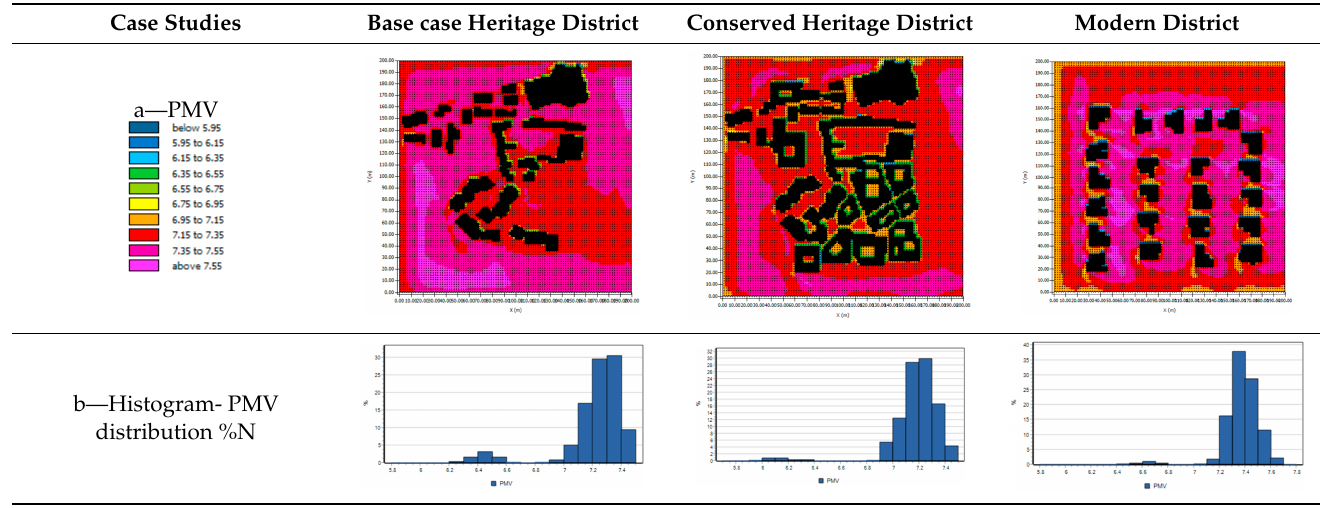
Table 7. The PMV, MRT, humidity, and wind speed for the base case heritage district, conserved